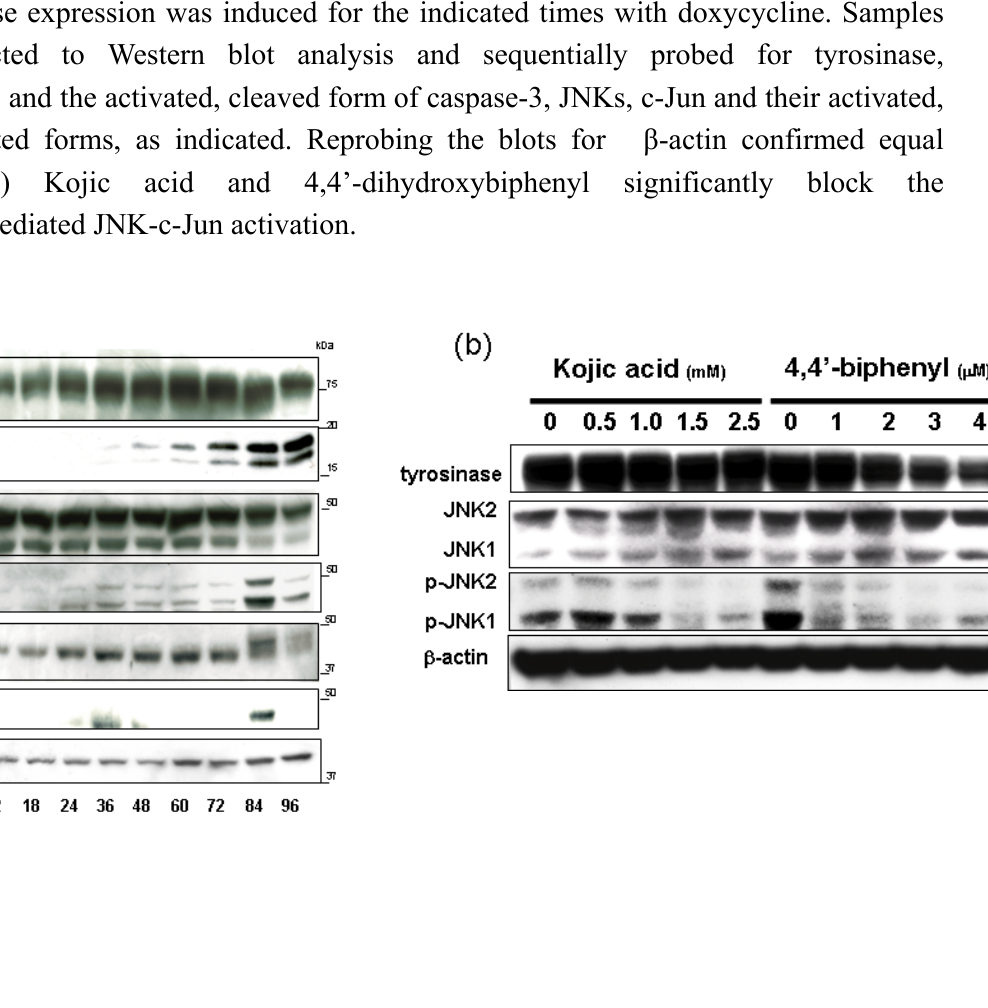
Figure 3. Tyrosinase induction causes activation of SAPK and caspase-3 pathways. (a) Tyrosinase expression was induced for the indicated times with doxycycline.